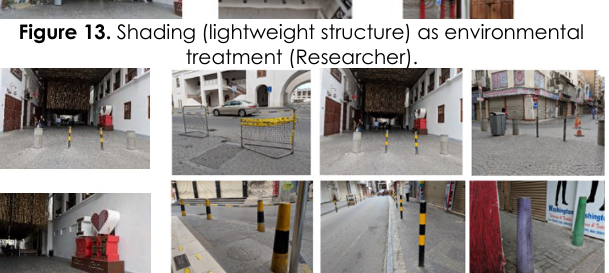
Figure 14. Street sidewalks and barriers (Researcher).